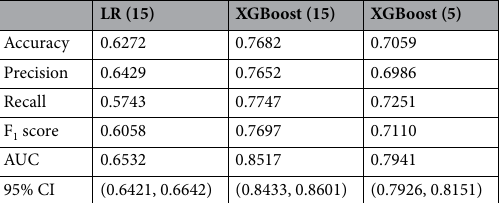
Table 3. A summary of LR and XGBoost predictions. The number in brackets represents the number of indicators input to the model.